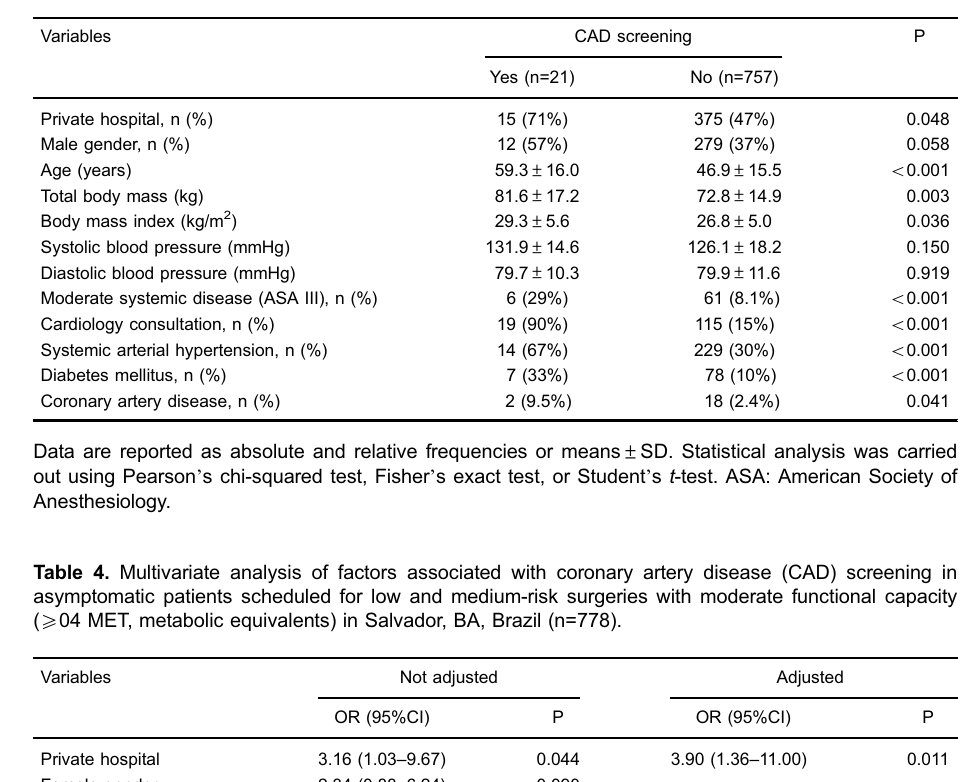
Table 3. Association between the studied parameters and screening for coronary artery disease (CAD) in asymptomatic patients scheduled for minor and medium-risk surgeries with moderate functional capacity ( X 4 MET, metabolic equivalents) in Salvador, BA, Brazil (n=778).